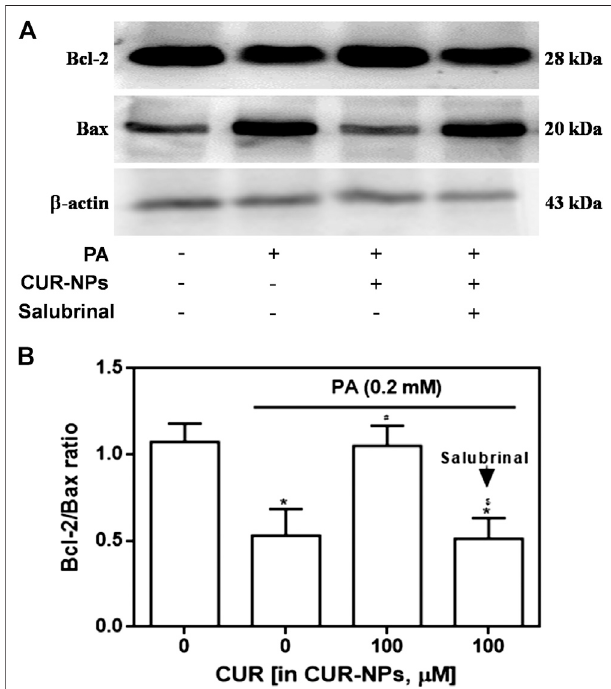
FIGURE 8 | Effect of salubrinal pretreatment on the anti-apoptotic effect ofCUR-NPsincardiomyocyteswithlipotoxicinjury (A) Representativeimages of Bax and Bcl-2 expression by western blot (B) Quantitative analysis of the Bcl-2/Bax ratio. Salubrinal: 30 μ M * p < 0.05 vs control group; # p < 0.05 vs PA group; $ p < 0.05 vs PA + CUR